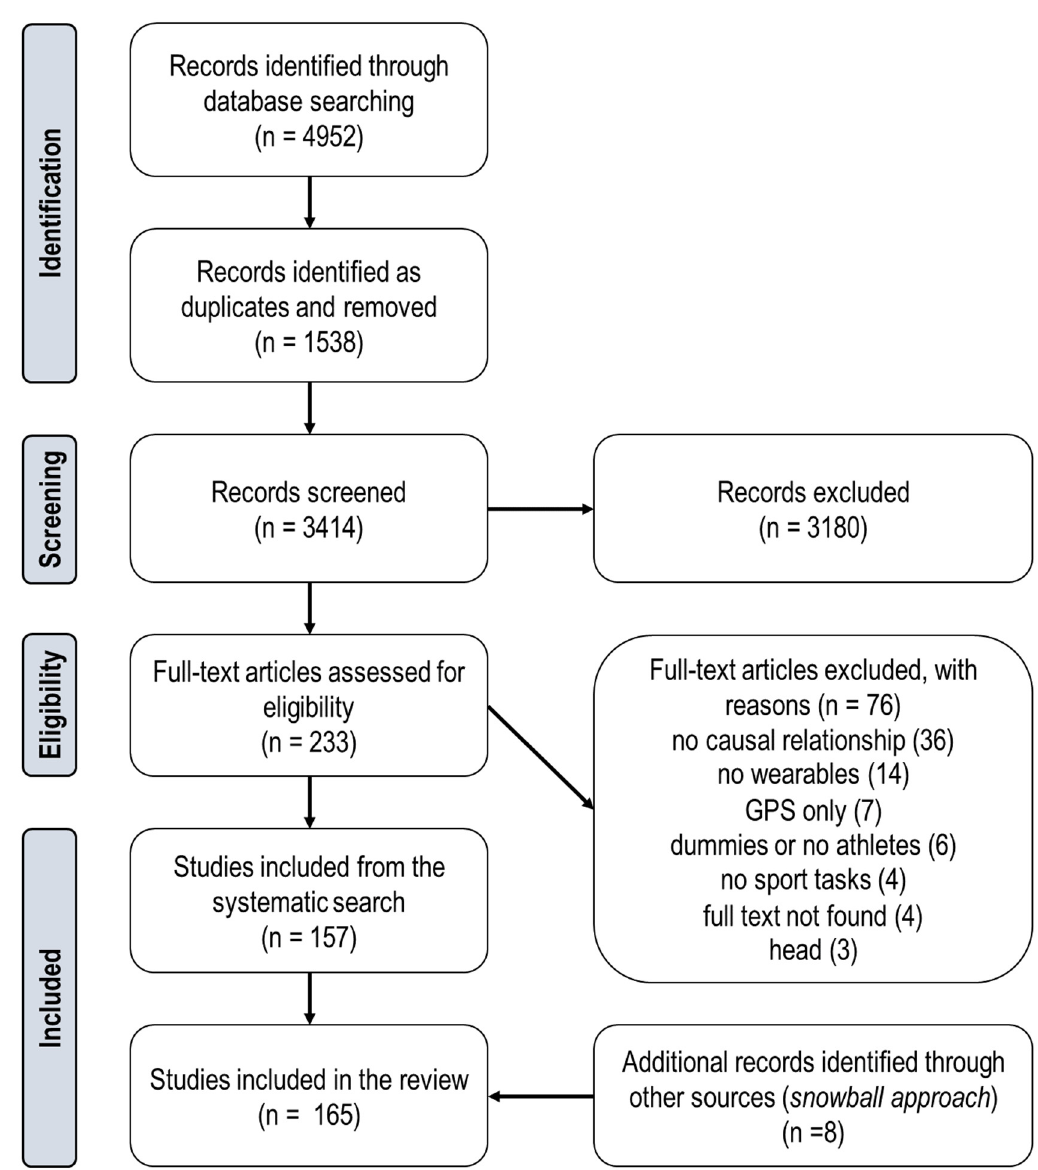
Figure 2. The PRISMA-ScR flowchart, showing the search and selection process.